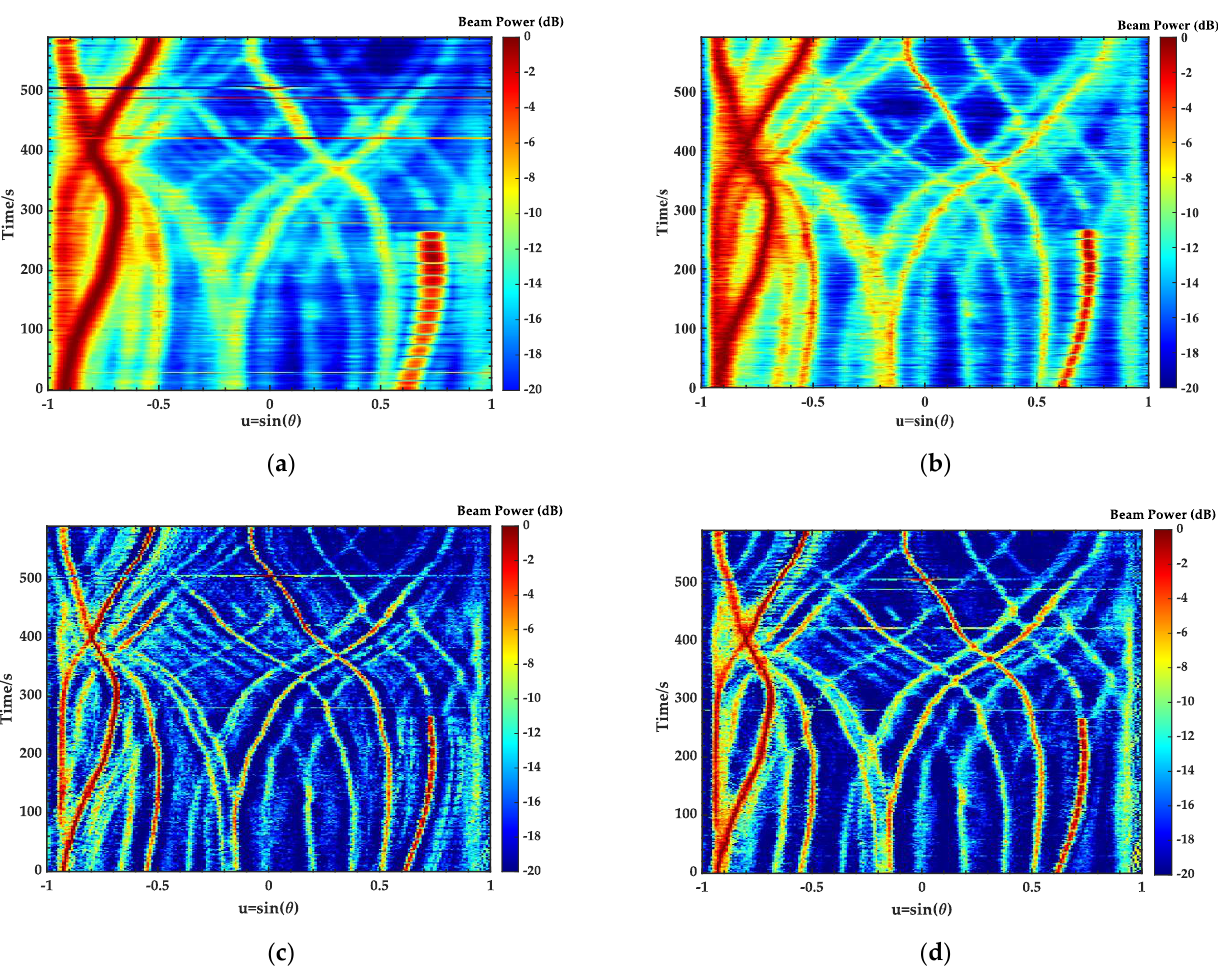
Figure 11. Towed array sonar bearing the time record results from ( a ) CBF; ( b ) SPED; ( c ) MVDR-FB-FL; ( d ) dCv-SPED.